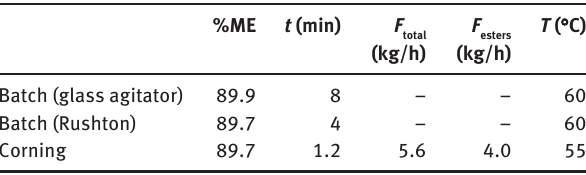
Table 3 Comparison of time required to obtain a certain mass frac- tion of esters in the Corning ® and batch